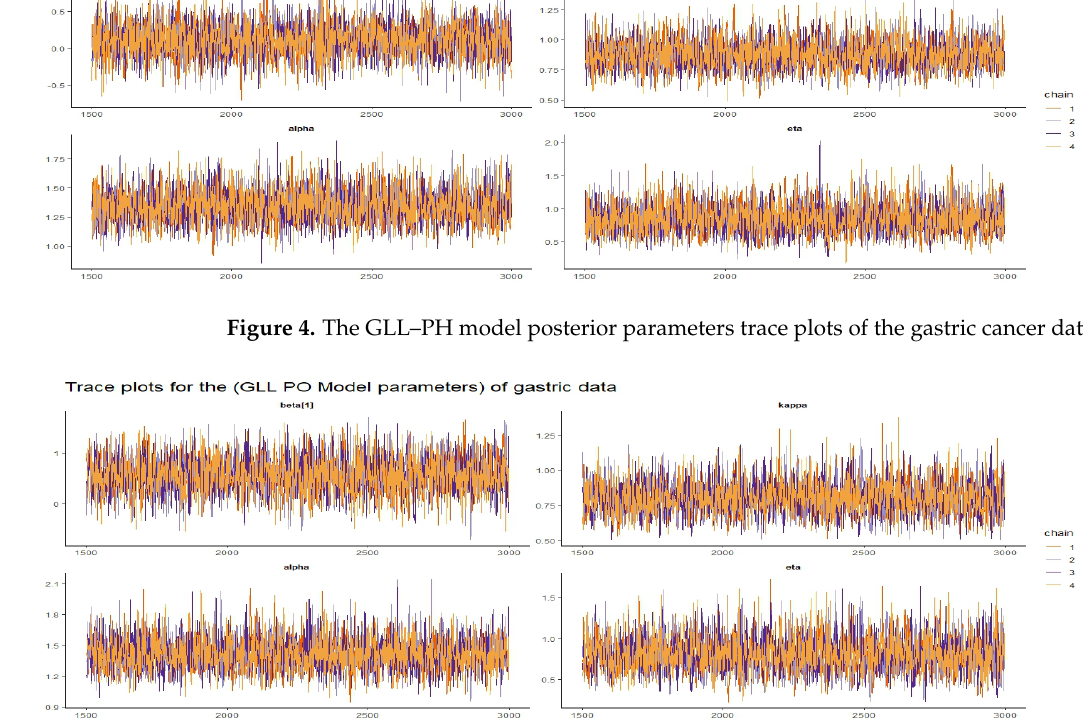
Figure 5. The GLL–PO model posterior parameters trace plots of the gastric cancer